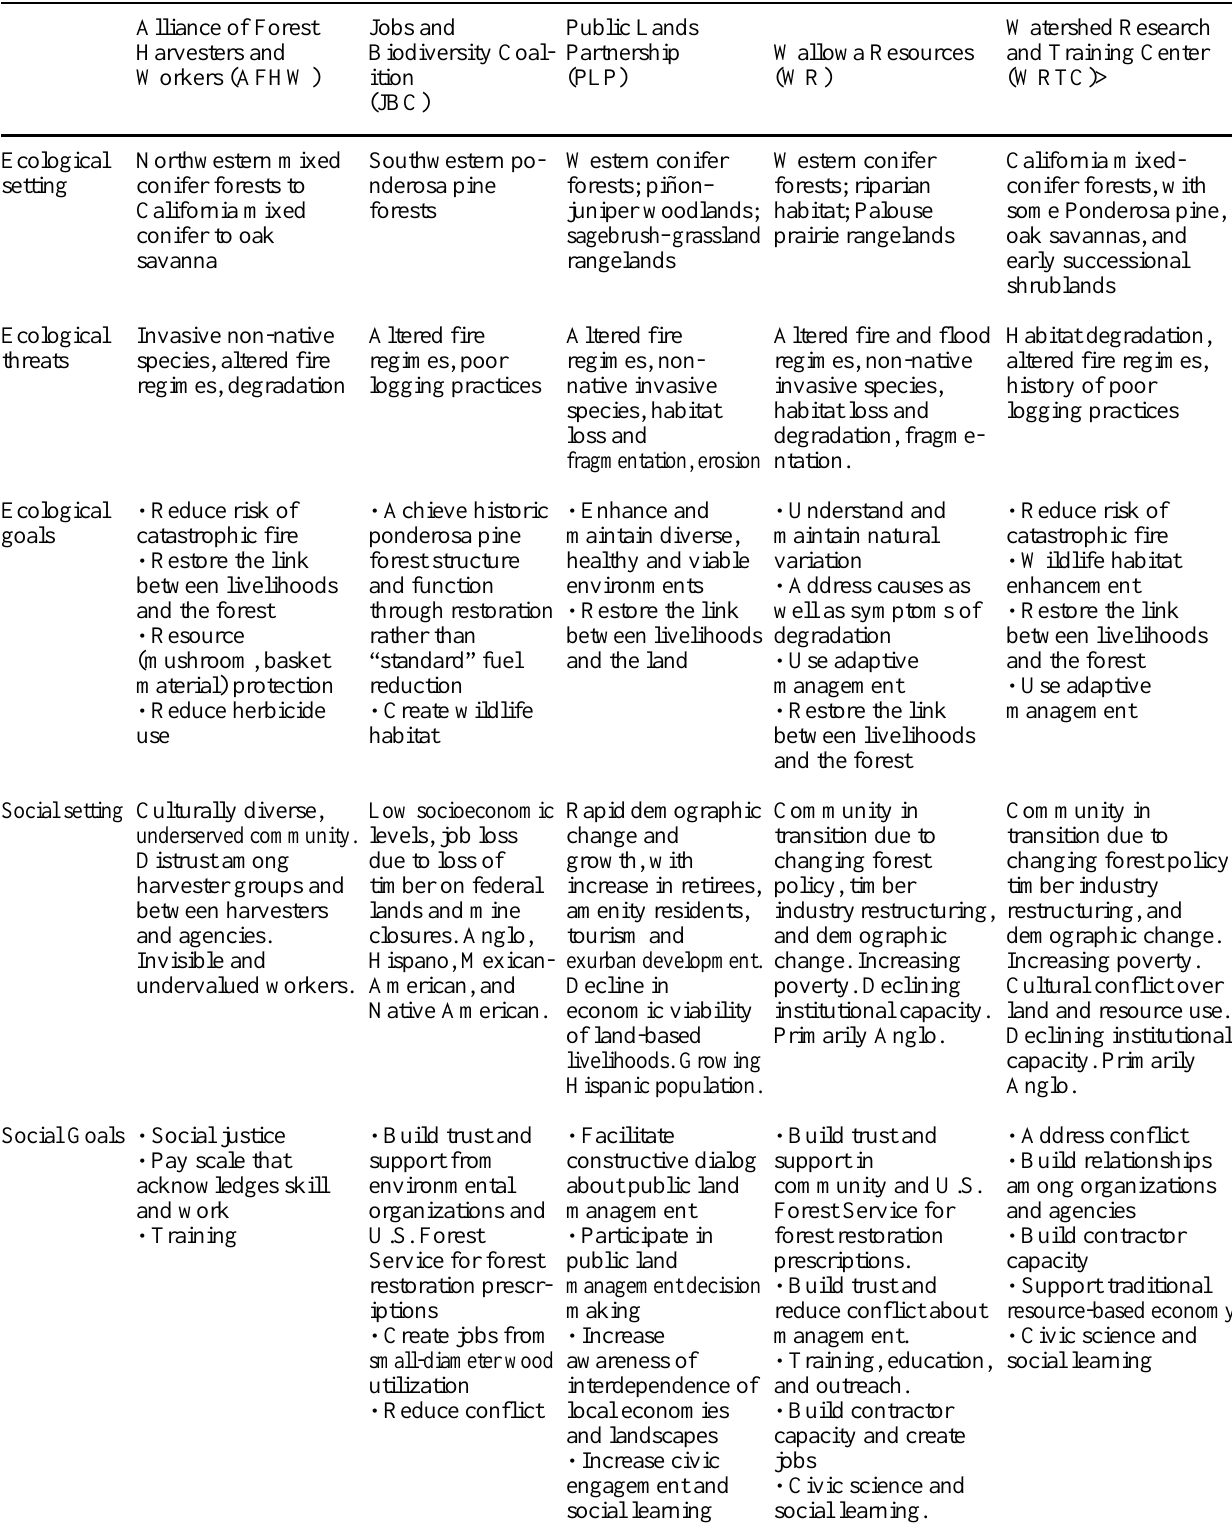
Table 1. Ecological and social settings and goals of five community-based forestry groups in the western